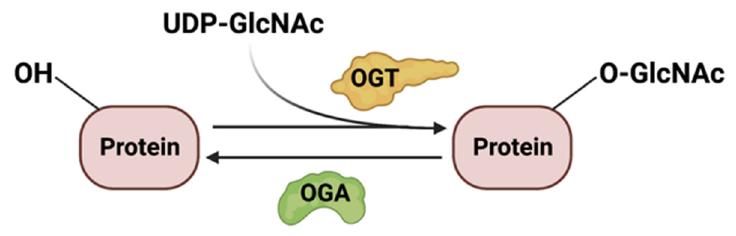
Figure 5. The O -GlcNAcylation of proteins is dynamically regulated by O -GlcNAc transferase (OGT) and O -GlcNAcase (OGA).